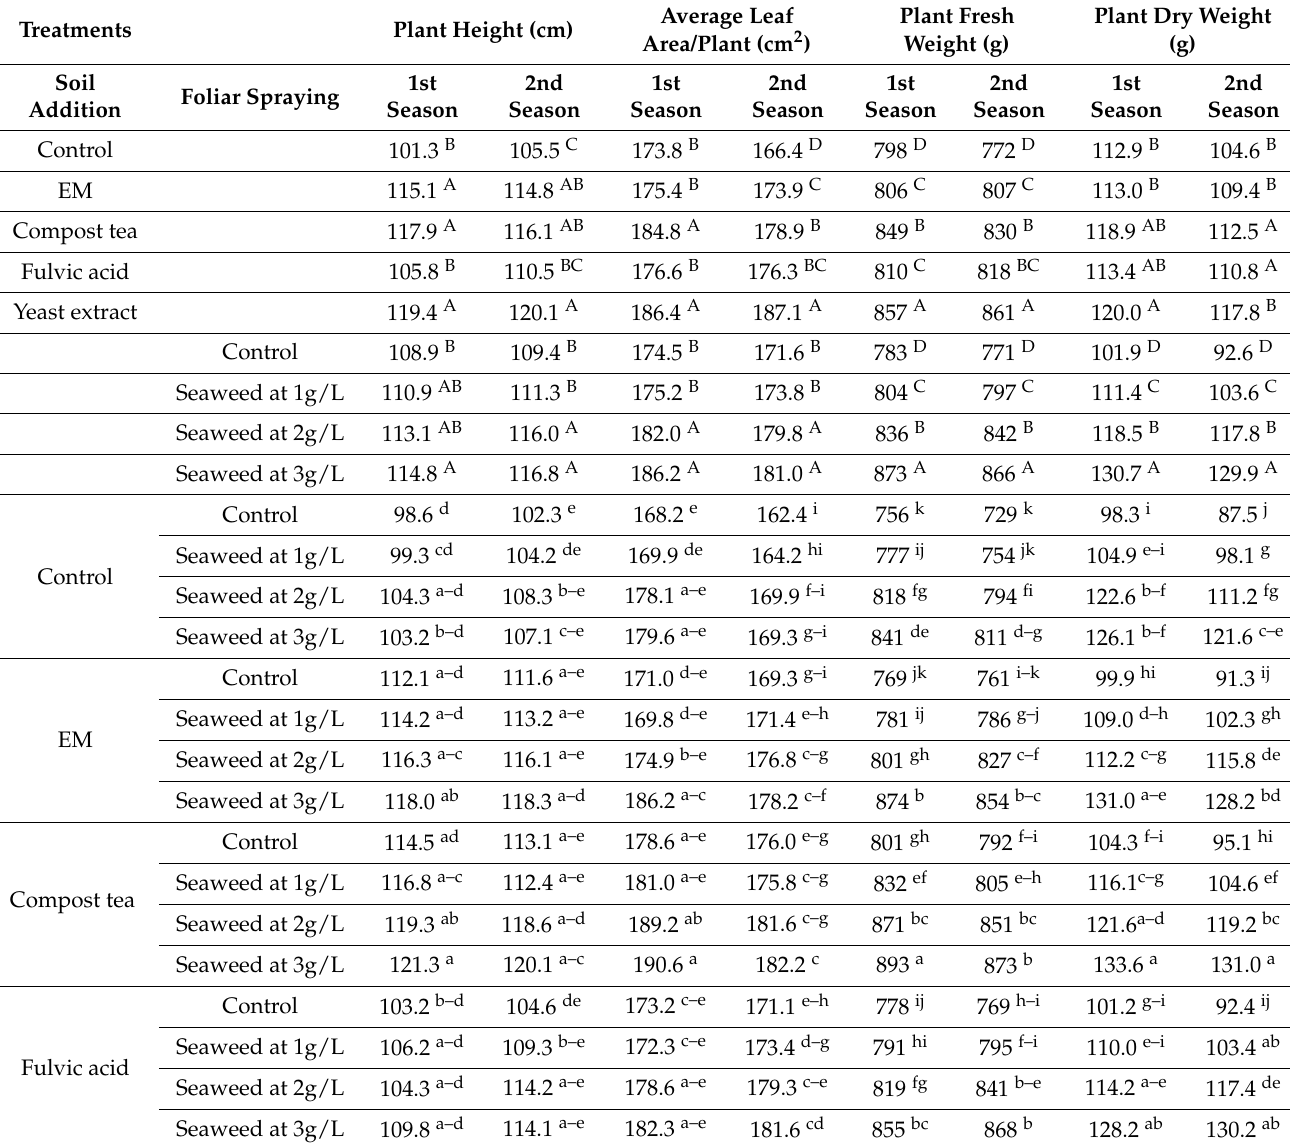
Table 1. Effects of the soil addition of EM, compost tea, fulvic acid, yeast extract, and foliar spray with seaweed extract and their combinations on the vegetative growth of sweet pepper plants during the 2019/2020 and 2020/2021